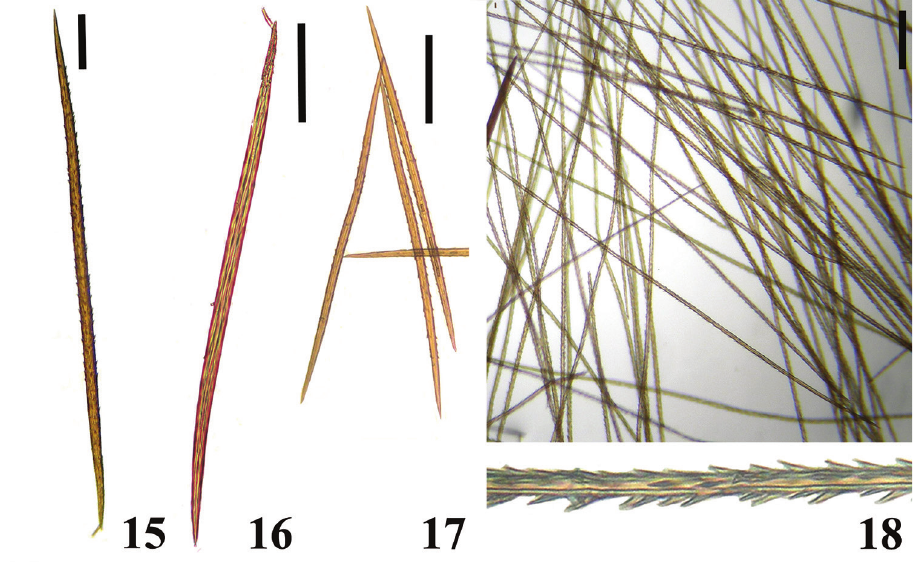
Figures 15–18. Urticating setae type II in Aviculariinae. 15 Avicularia juruensis male (CAS 4), showing well-developed barbs along all its length 16 Avicularia variegata stat. n. female (IBSP 7900), showing weakly-developed barbs only near the stalk 17 Avicularia avicularia female morphotype 5 (MNRJ 06916) from Pando, showing developed barbs along almost entire length 18 Caribena versicolor comb. n. male (MNHN−AR 4904), very slender setae with barbs along all length. Scale bars = 0.1